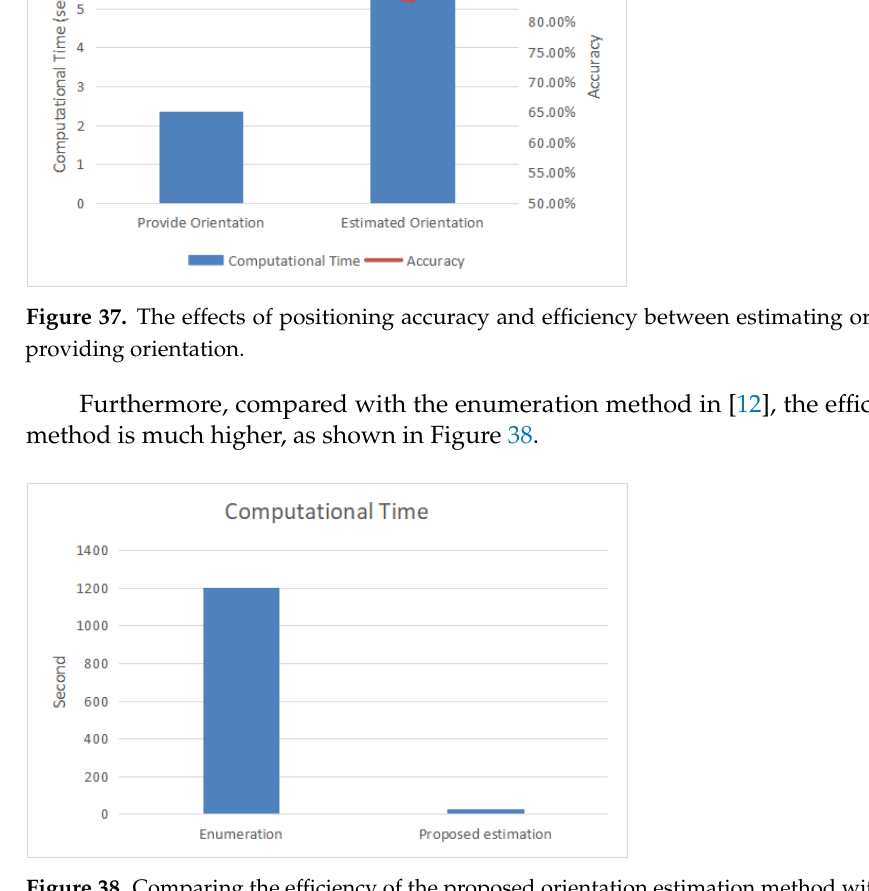
Figure 38. Comparing the efficiency of the proposed orientation estimation method with the enumer- ation method in [12]. The range of roll and pitch of the enumeration method are both [ − 5 ◦ , 5 ◦ ], step size is 0.1 ◦ , and yaw step size is 1 ◦ .